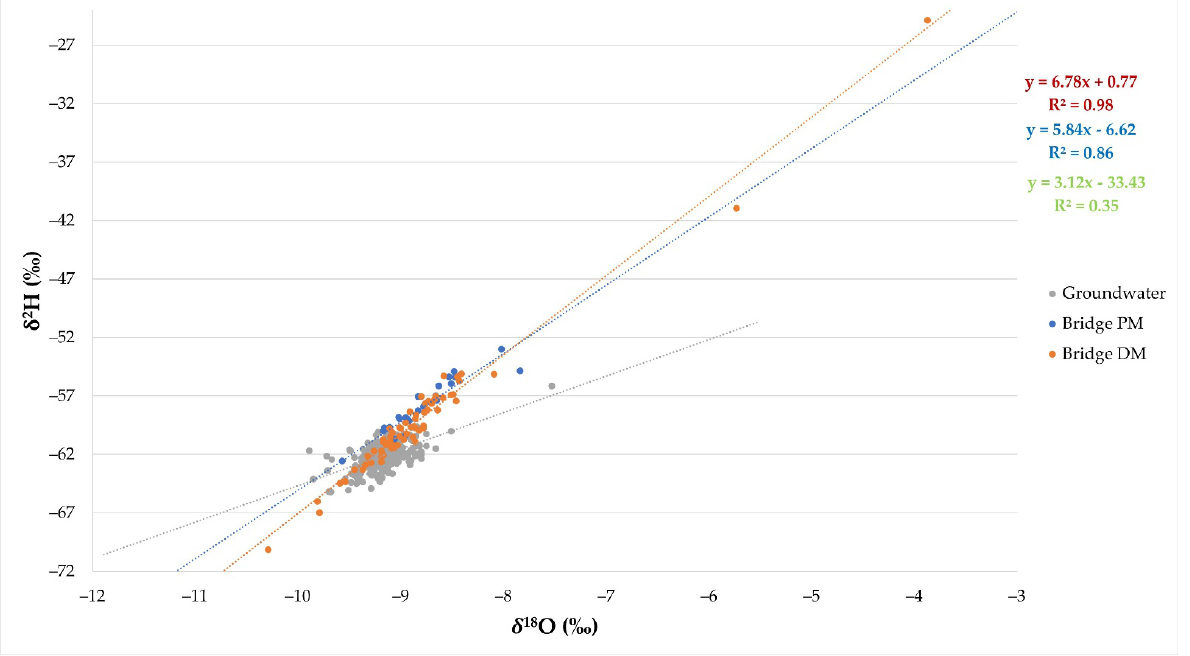
Figure 5. Dual plot of isotope composition of groundwater and the Sava River in the area of the Zagreb aquifer.